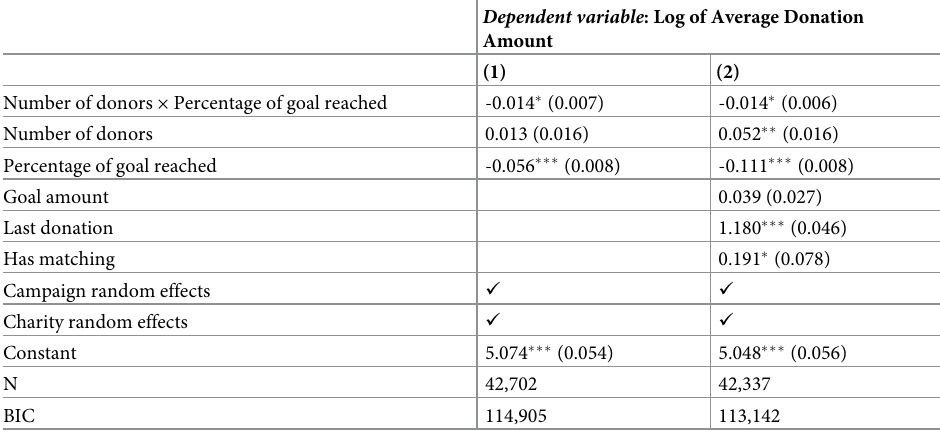
Table 2. Study 1 regressions